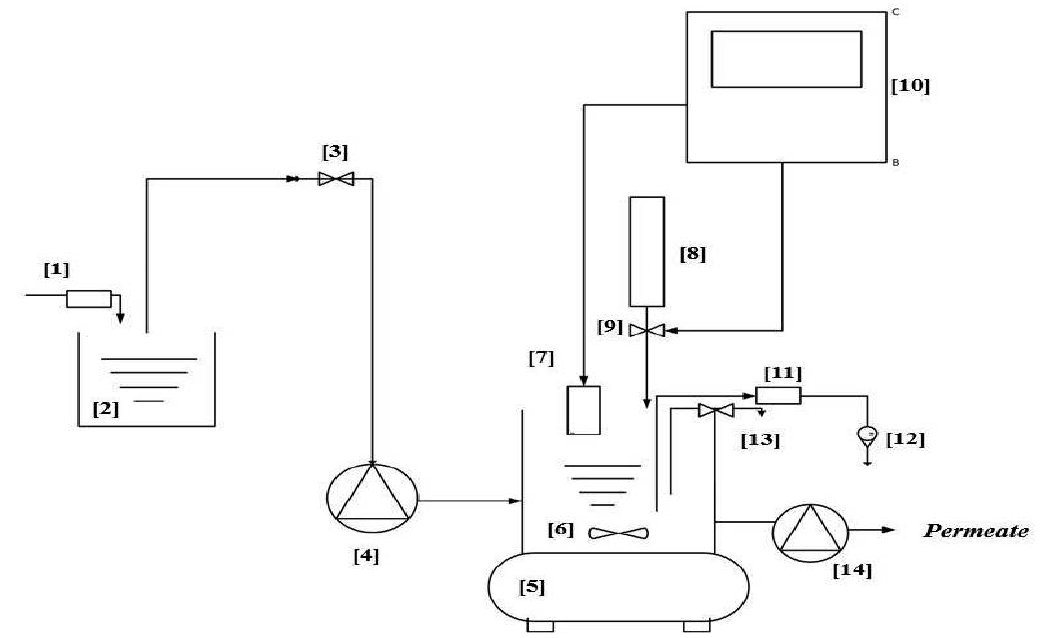
Figure 1. Schematic diagram of the continuous culture reactor (CSTR) (1) Air Filter (2) Feed vessel (3) valve (4) Feed pump (5) Magnetic stirrer plate (6) Stirring bar (7) pH probe (8) Alkali reservoir (9) valve (10) pH controller (11) Air filter (12) Rotameter (13) Sampling port (14) Effluent pump. Membrane Bioreactor (MBR) Unit Design